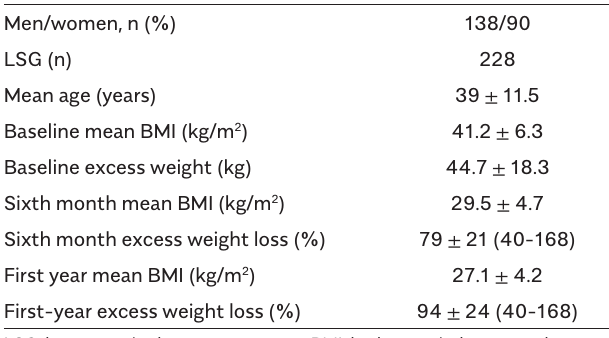
Table 2. Patient Demographics and Weight Loss